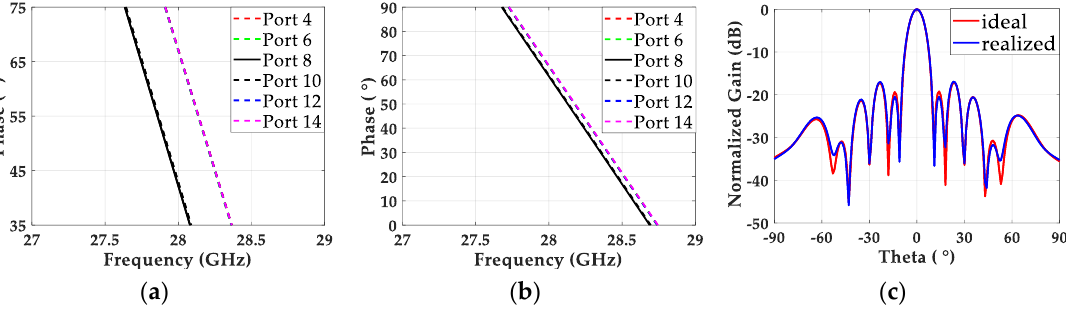
Figure 5. Phase delays from the input port to output ports 4, 6, 8, 10, 12 and 14 when ( a ) L1 = 16.37 mm and ( b ) L1 = 16.11 mm. ( c ) Normalized gain along theta ( θ ) of the 12 patch elements individually fed by the realized amplitudes and phases from the designed power divider and the ideal values.